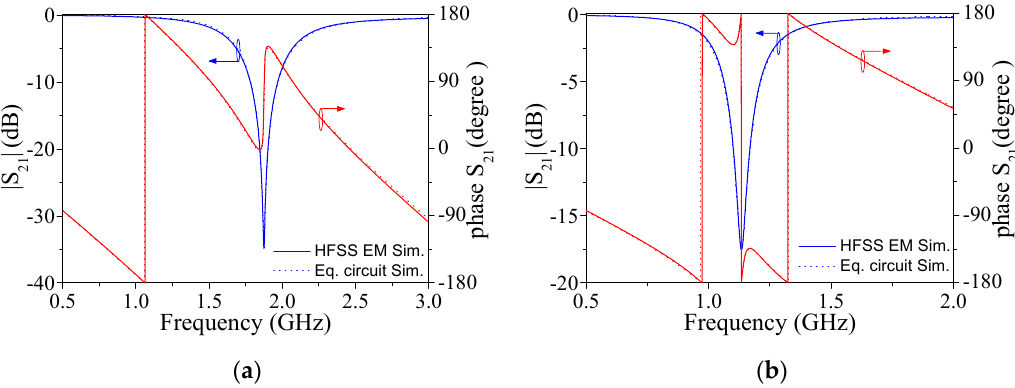
Figure 3. Transmission coe ffi cient (magnitude and phase) of the reference (REF) channel without liquid ( a ), and with deionized (DI) water ( b ), inferred from electromagnetic and circuit simulation. The element values of the equivalent circuit model are (in reference to Figure 2): Z 0 = 50 Ω , kl = 78.51 ◦ , L = 2.40 nH, C = 2.51 pF, C ref = 5.74 pF, G = 0.18 mS, and G ref = 1.31 mS. Note that in the circuit simulations of (a), C ref = 0 pF and G ref = 0 mS, as corresponds to the absence of any liquid in the